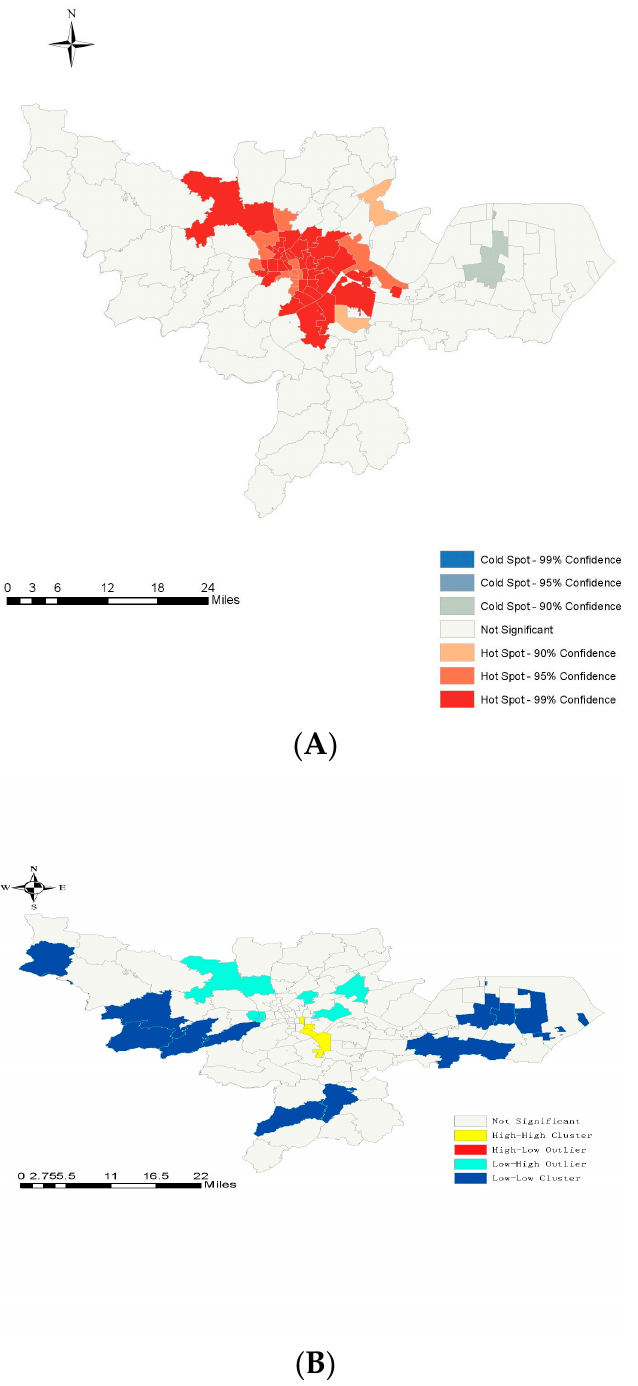
Figure 1. Spatial distribution of Lifts installation hot spots and cold using different approaches. ( A ) Optimized Getis–Ord (OGO) ( B ) local Moran’s I (COA) results.